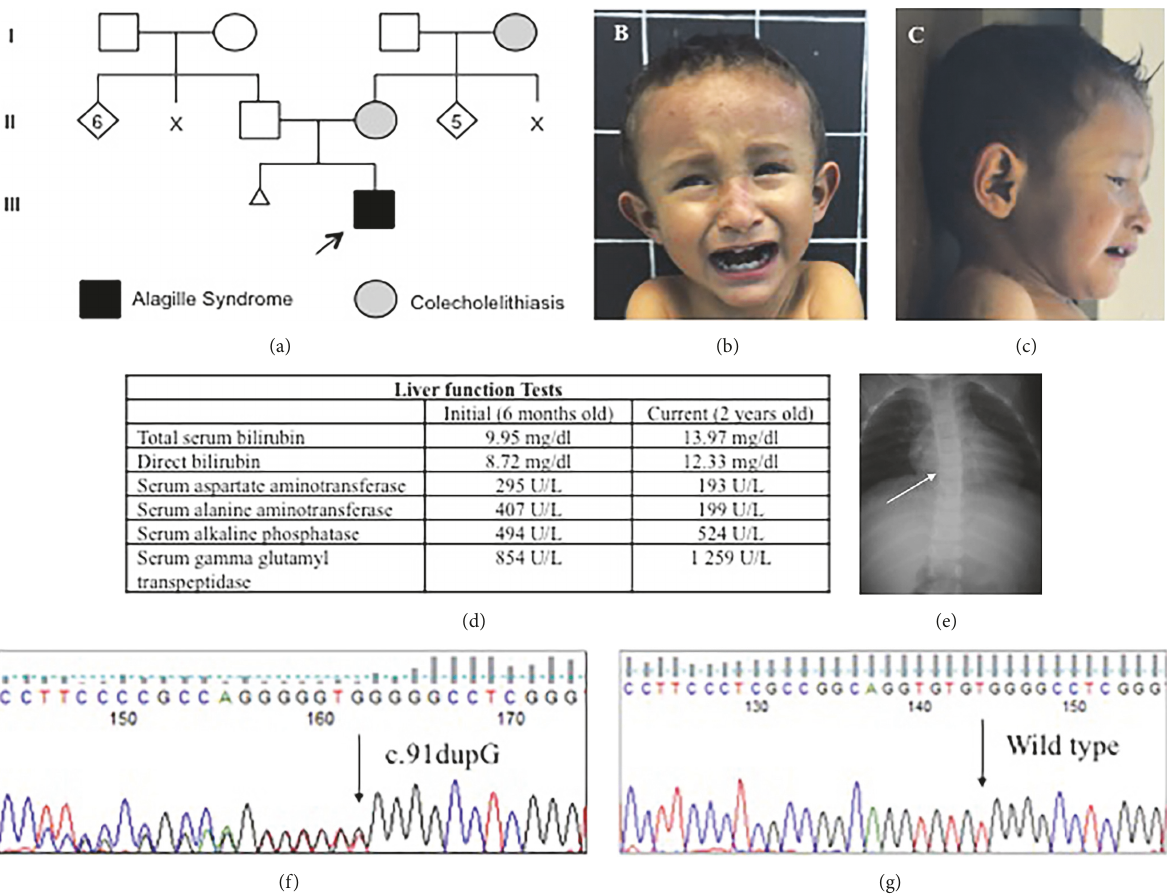
Figure 1: (a) Pedigree of the family of the proband. (b) Facial clinical characteristics of the proband. Note the triangular face, wide forehead, and prominent chin. (c) Deep-set eyes. (d) Altered liver function analysis. (e) X-ray analysis showing butterfly-like dorsal vertebra (white arrow). (f) Capillary sequencing analysis demonstrating the mutation in the proband. (g) Wild-type sequence in one of the